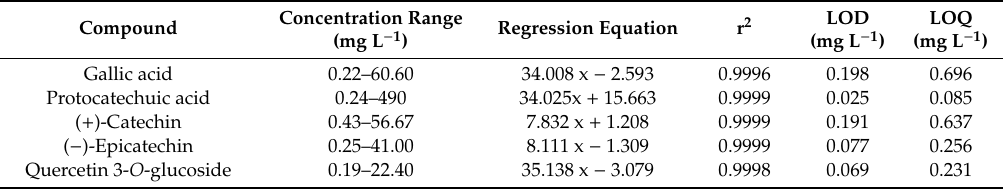
Table 2. Parameters of linear regression, LOD and LOQ for phenolic compounds by HPLC analysis.